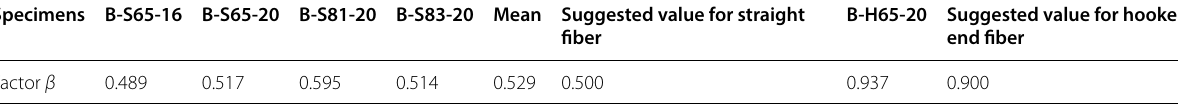
Table 7 Strength reduction factor ( β ) of specimens.